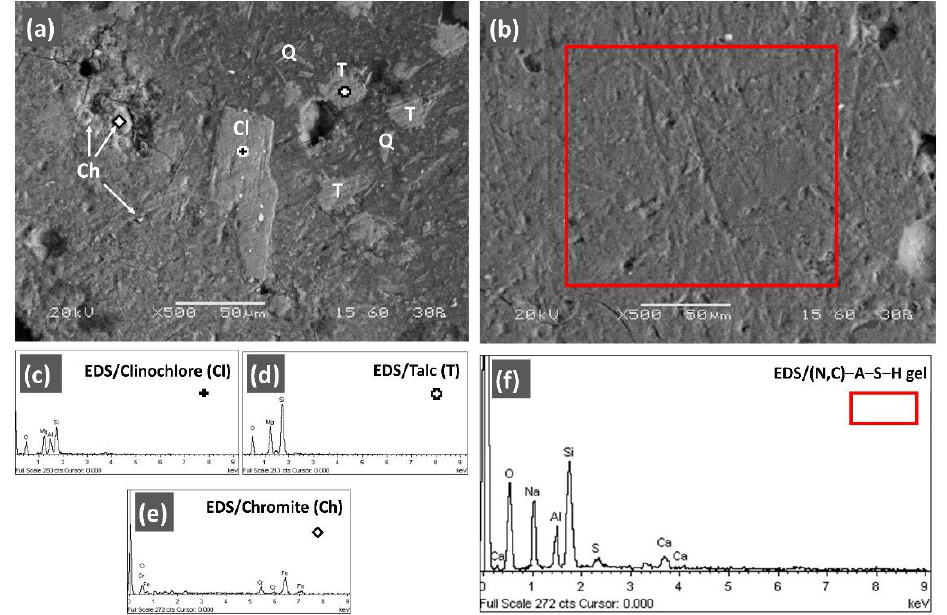
Figure 6. Cross-sectional SEM images of selected AAMs produced by mixing Polish laterite leaching